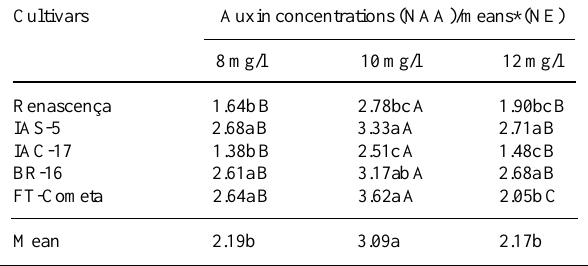
*Means followed by the same lower case letters in the column and by the same upper case letters in the line did not differ at 5% level of prob- ability by the Tukey